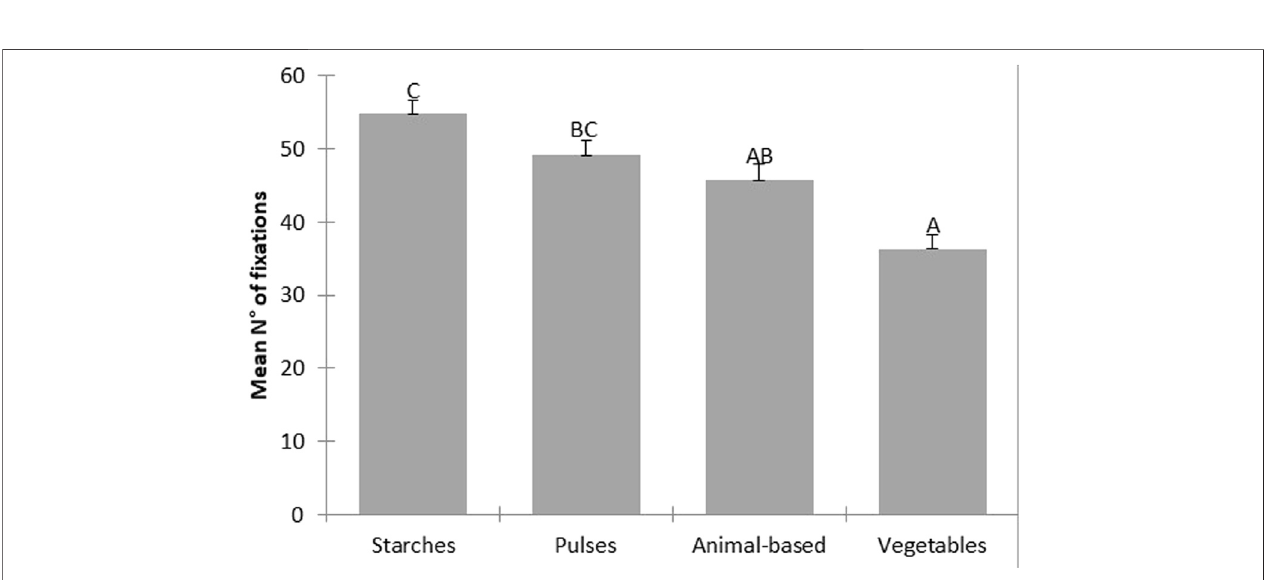
FIGURE 5 | Mean number of fi xations for each food-group. Letters indicate a comparable number of fi xations across food-groups (two-tailed Nemenyi test; p < 0.05).